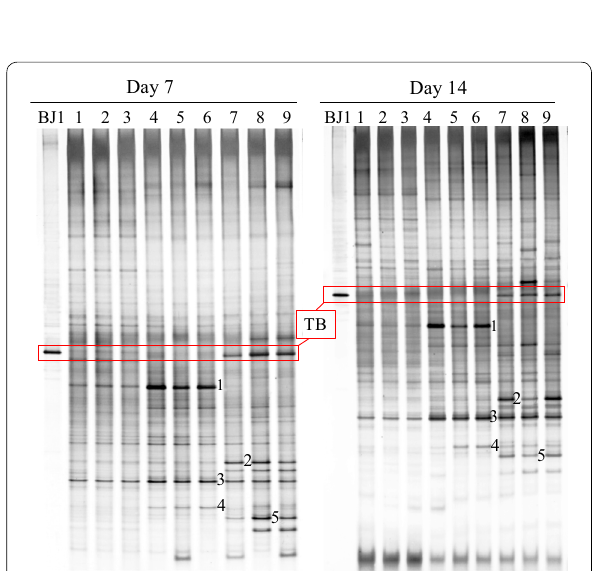
Fig. 2 DGGE profile of strain BJ1 and soil bacteria. Lanes: 1, 2, and 3, Control; 4, 5, and 6, NC treatment; 7, 8, and 9, NCB treatment.